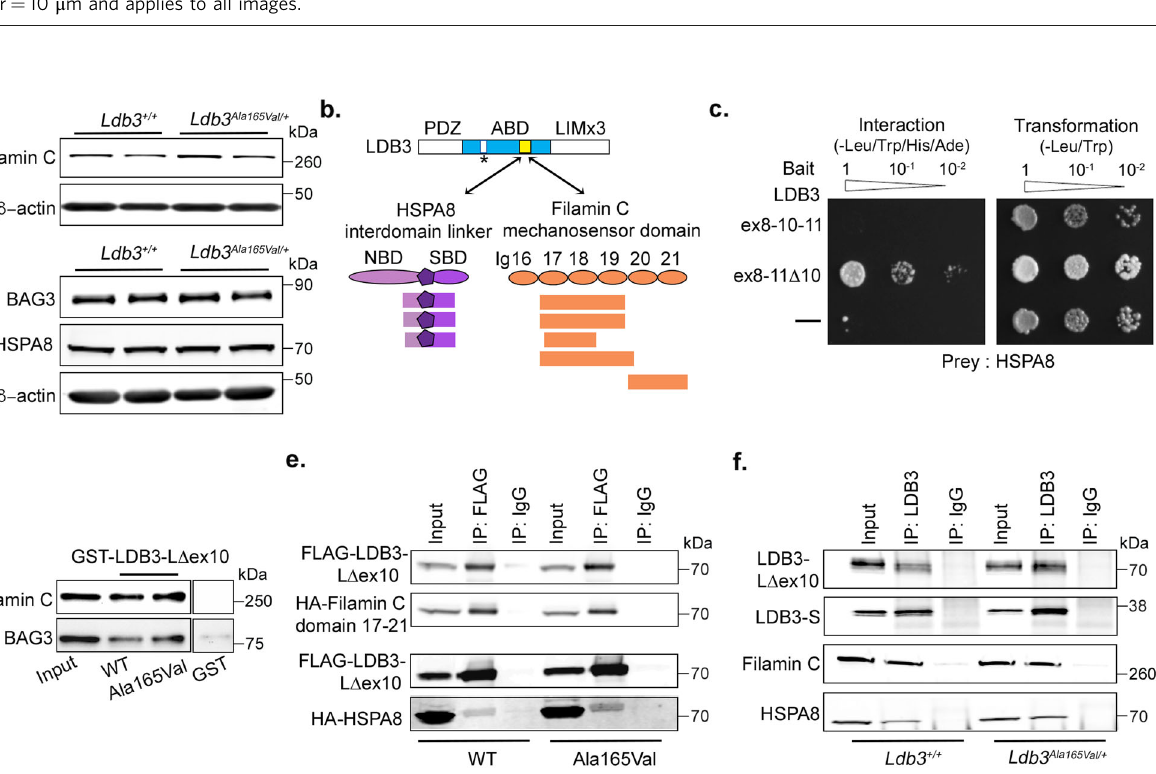
Fig. 4 Progressive protein aggregation and Z-disc myo fi brillar disruption in skeletal muscle of Ldb3 Ala165Val/ + mice. Representative immuno fl uorescence staining on perfused tibialis anterior muscle consecutive longitudinal sections of 4-month-old ( a – e ) and 8-month-old ( f – j ) Ldb3 Ala165Val/ + mice and their Ldb3 + / + littermates. a Muscle sections of 4-month-old Ldb3 + / + mice ( n = 4) show normal Z-disc staining for LDB3, fi lamin C, myotilin, BAG3, and HSPA8 proteins. b , c Muscle sections of 4-month-old Ldb3 Ala165Val/ + mice ( n = 6) show same muscle fi ber co-stained with LDB3 and fi lamin C antibodies ( b ), and LDB3 and myotilin antibodies ( c ). d , e Muscle sections of 4-month-old Ldb3 Ala165Val/ + mice ( n = 6) show same muscle fi ber co-stained with fi lamin C and HSPA8 antibodies ( d ), and BAG3 and HSPA8 antibodies ( e ). Filamin C, HSPA8, and BAG3 aggregates are seen at the Z- disc spanning multiple sarcomeres in same fi ber. In contrast, the LDB3 and myotilin antibodies show normal Z-disc staining in the fi ber with fi lamin C aggregates. f Muscle sections of 8-month-old Ldb3 + / + mice ( n = 5) show normal Z-disc staining for LDB3, fi lamin C, myotilin, BAG3, and HSPA8 proteins. Top and bottom panel each shows same muscle fi ber co-stained with LDB3 and fi lamin C antibodies ( g ), and LDB3 and myotilin antibodies ( h ) in muscle sections of 8-month-old Ldb3 Ala165Val/ + mice ( n = 7). Muscle sections of 8-month-old Ldb3 Ala165Val/ + mice ( n = 7) show same muscle fi ber co-stained with LDB3 and BAG3 antibodies ( i ), and LDB3 and HSPA8 antibodies ( j ). LDB3 aggregates colocalize with fi lamin C, myotilin, BAG3, and HSPA8 at the Z- discs in muscle fi bers. The protein aggregates are seen in muscle fi bers with normal periodicity of the Z-discs and with disorganized Z-disc periodicity indicating Z-disc myo fi brillar disruption. A part of adjacent muscle fi ber with normal staining pattern is shown at bottom in each image for comparison. Scale bar = 10 μ m and applies to all images.